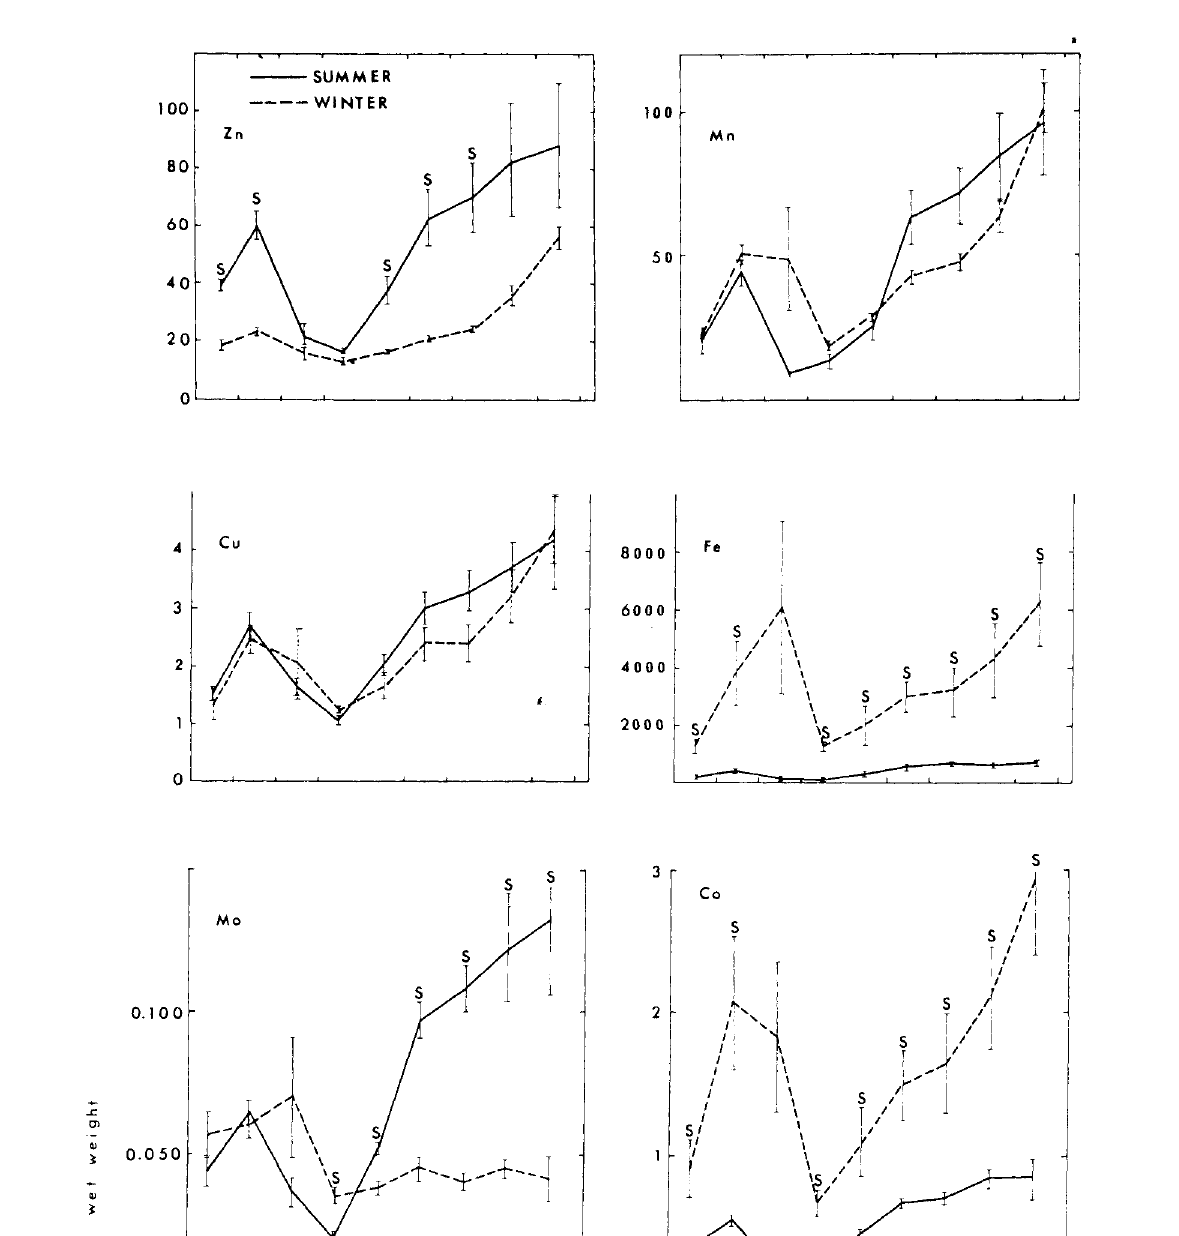
Fig. 2. Concentrations Of trace elements in the F 'S- Sporstoffkonsentrasjoner i fordøyelsessystemet gastrointestinal tract of Svalbard reindeer. For Svalbard-rem. For videre forklaring se fig. 1. further explanations see fig.